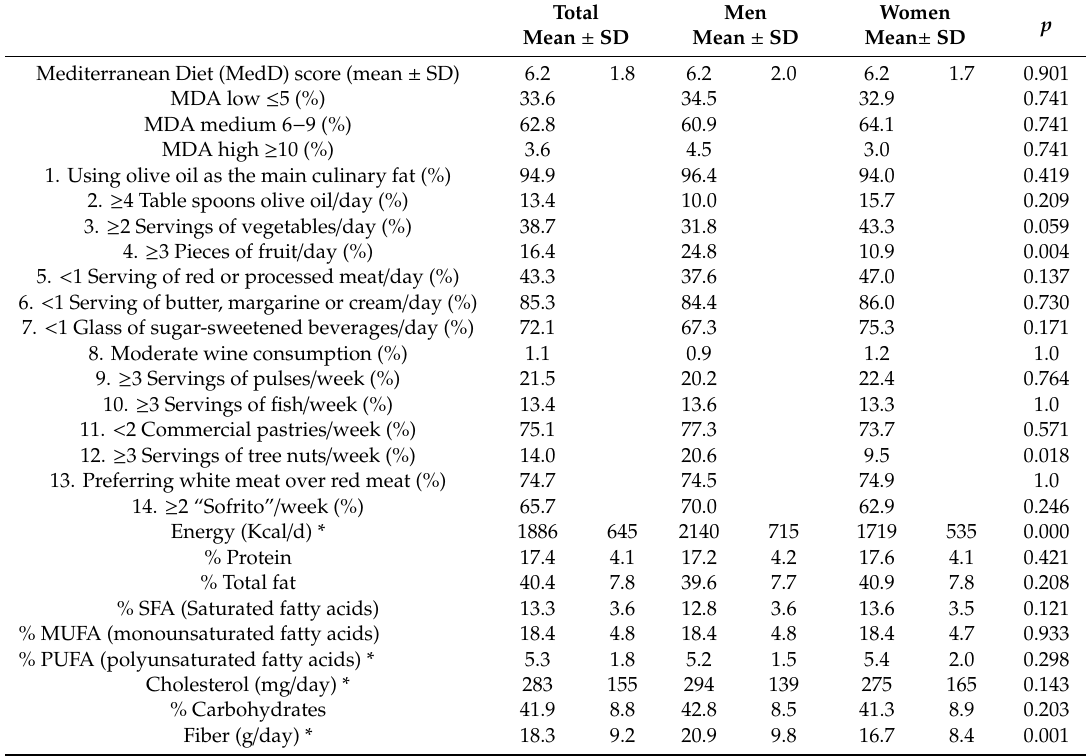
Table 2. Fulfillment of the specific Mediterranean diet adherence items and 24-h dietary recall according to sex.